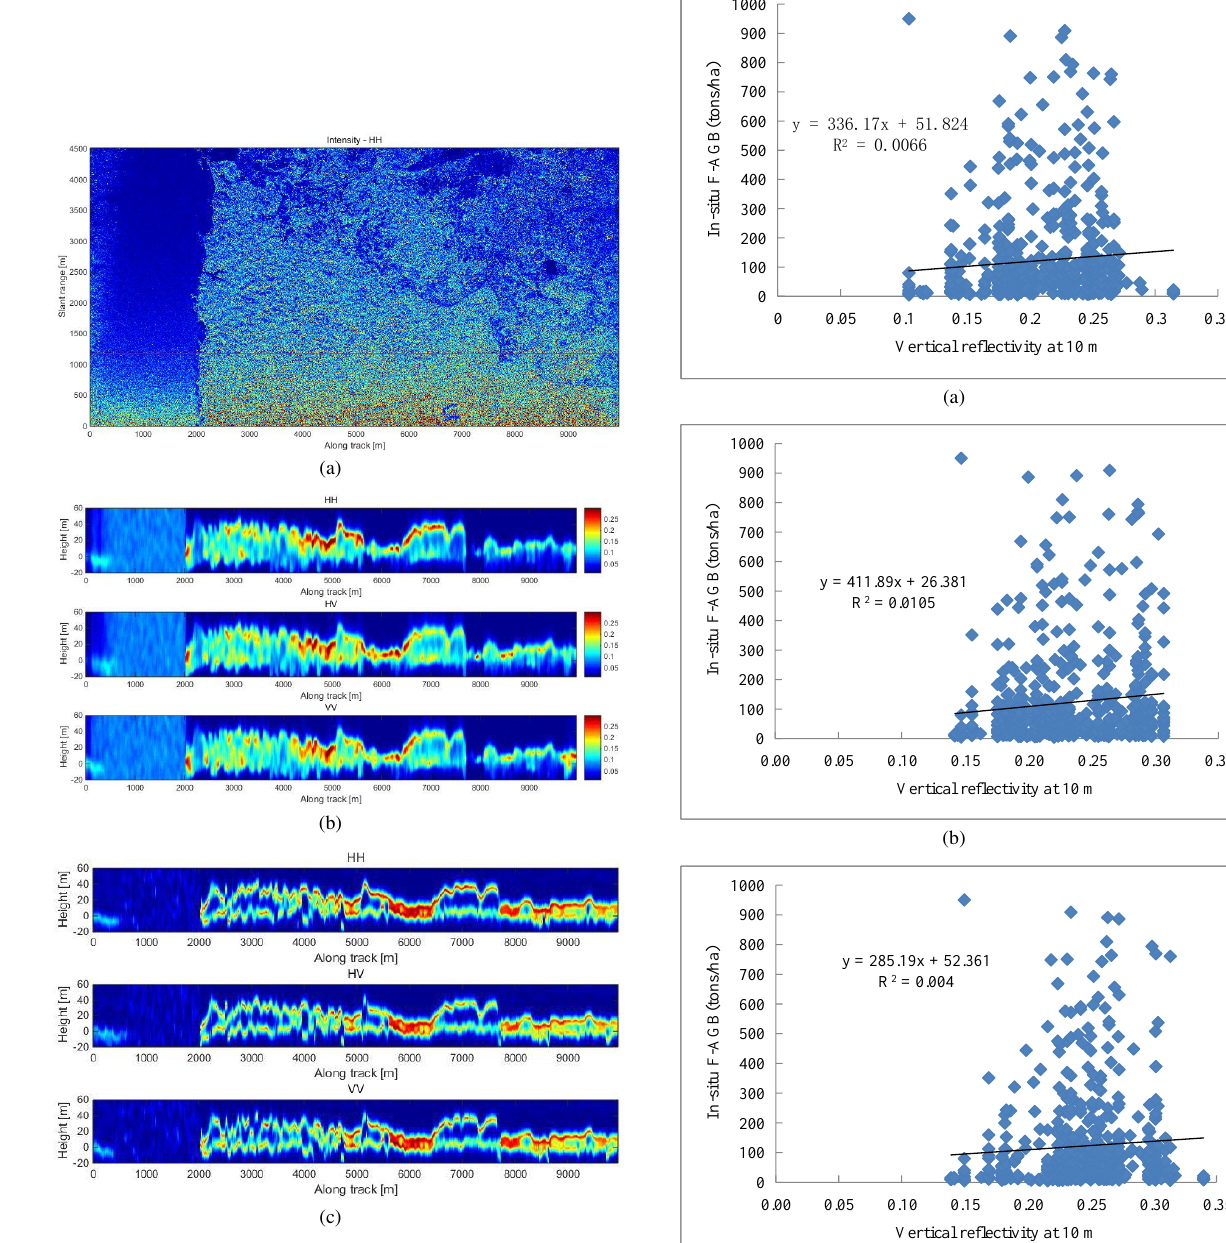
Figure 3. (a)The profile location in HH polarimetric channel, (b) the vertical reflectivity profiles in HH/HV/VV based on Capon method, and (c)vertical reflectivity profiles in HH/HV/VV based Figure 4. The correlation coefficient between the in-situ F-AGB on MUSIC approach. and vertical scattering reflectivity at 10 m height in (a) HH channel (b) HV channel and (c) VV channel,